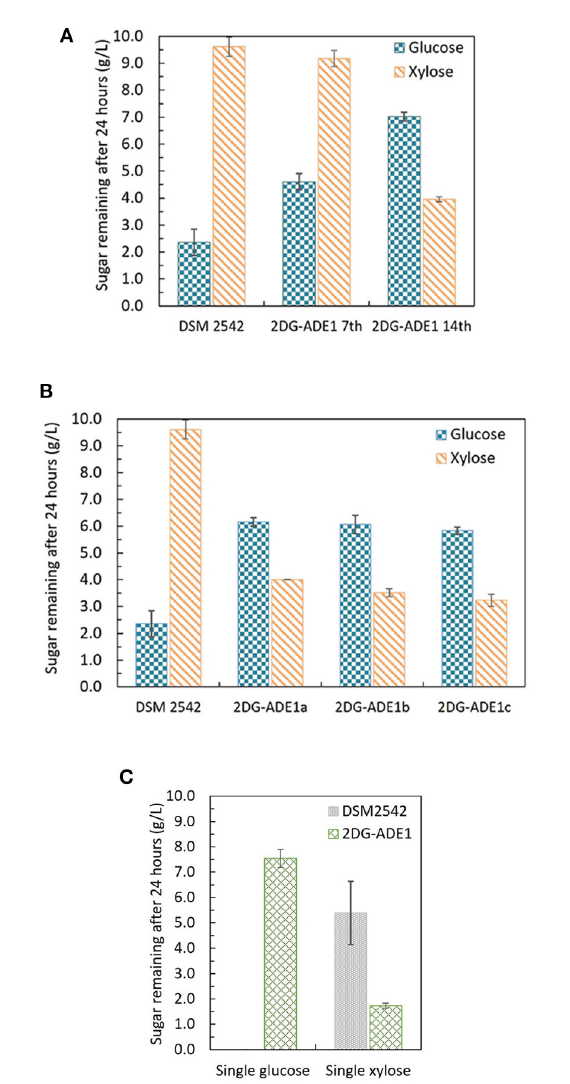
FIGURE6 Sugar consumption profiles of P. thermoglucosidasius DSM 2542, 2-DG resistant cultures after 7 and after 14 passages in 0.5% 2-DG and 1% xylose (2DG-ADE1 7th and 2DG-ADE1 14th), and 2-DG resistant isolates 2DG-ADE1a, 2DG-ADE1b and 2DG-ADE1c during tube fermentation in 15 mL sterile centrifuge tubes. Cells were cultured in ASM medium supplemented with 1% (w/v) glucose and 1% (w/v) xylose as in (A,B) , or (C) 1% (w/v) glucose or 1% (w/v) xylose alone. To stabilize the pH during the fermentation, 0.2 g MgCO 3 was added to the tubes prior to inoculation. Error bars in (A,B) and DSM 2542 from (C) are ± standard deviation of three replicates taken at the same time point. Error bars in (C) 2DG-ADE1 are ± standard deviation of 2DG-ADE1a, 2DG-ADE1b and 2DG-ADE1c samples taken at the same time point. A t -test performed on data in (A,B) confirmed the remaining glucose and xylose in cultures of DSM 2542 and the 2DG resistant strains were statistically different ( p <